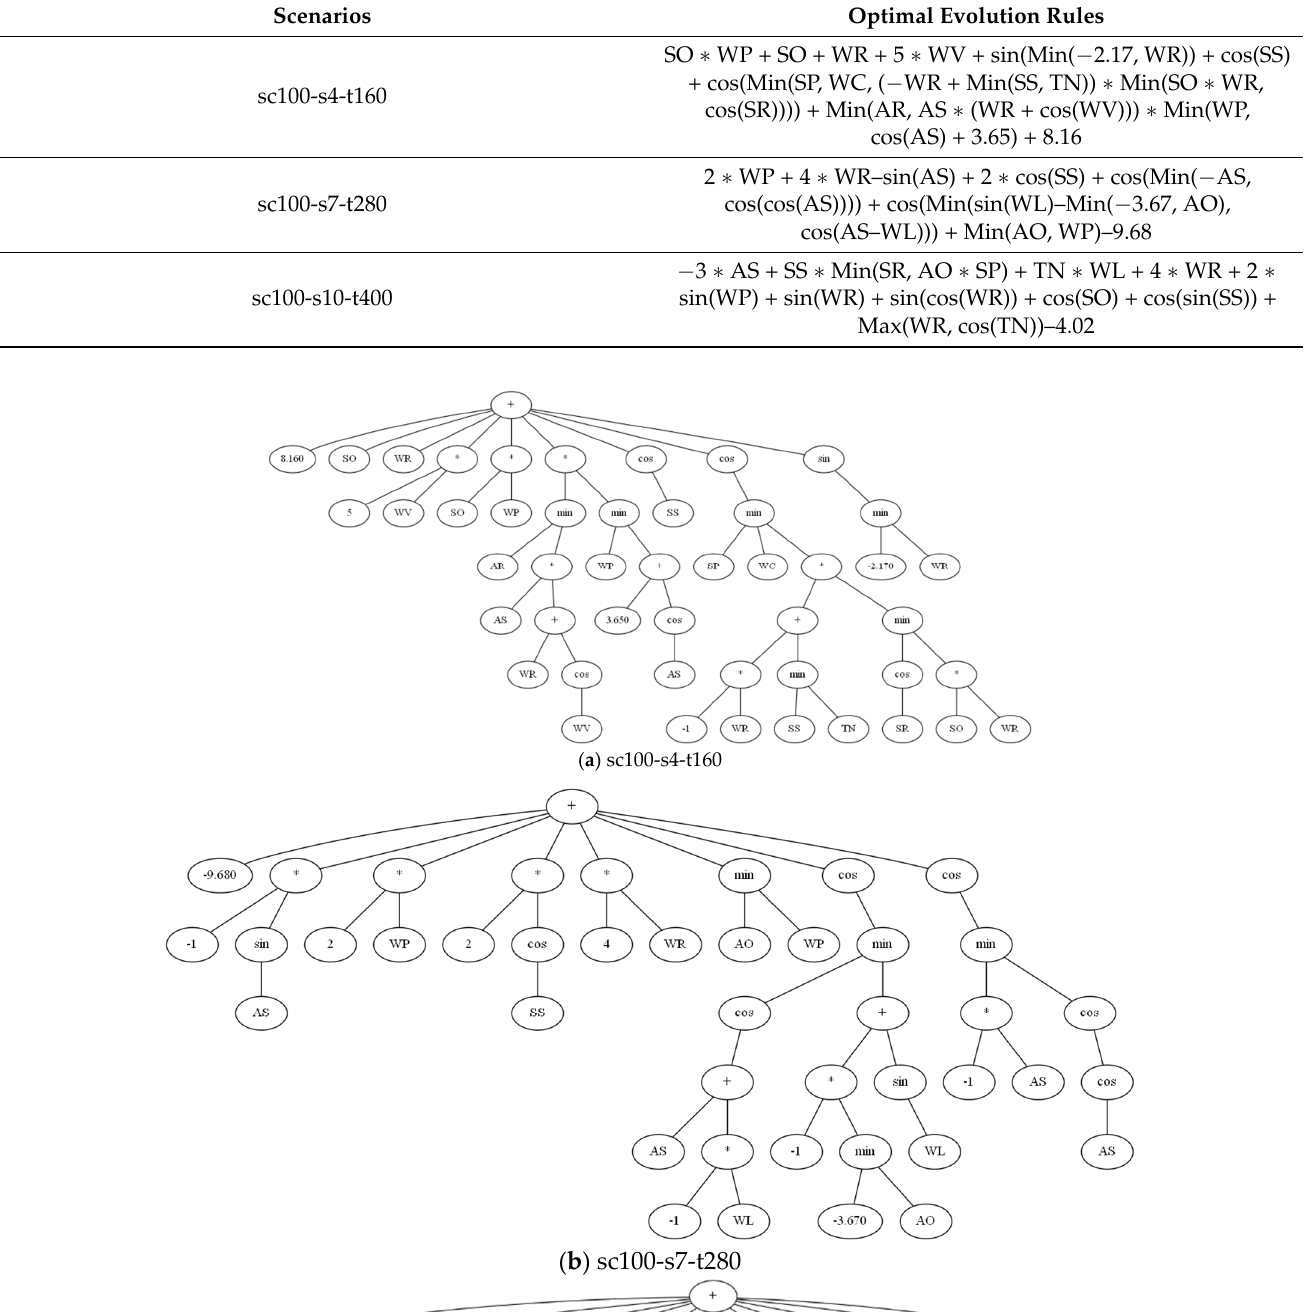
Table 7. The results of optimal evolution rules.